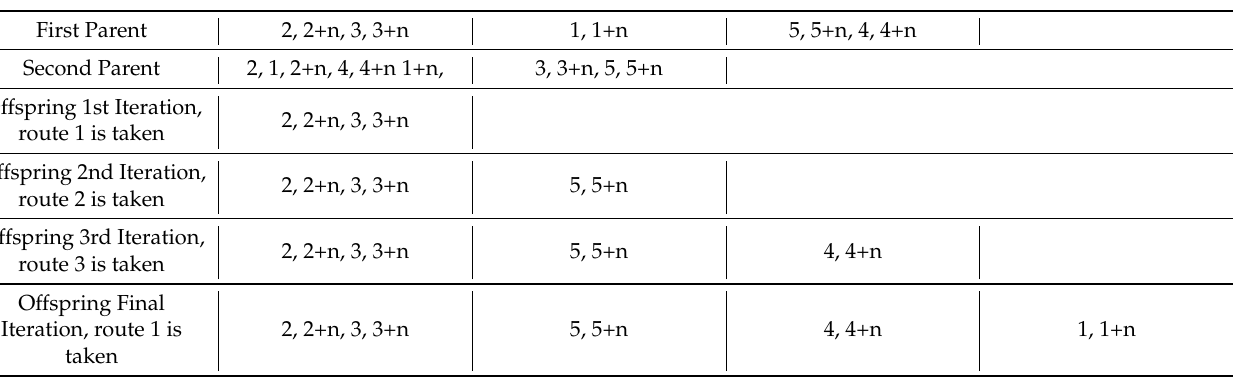
Figure 2. Example of crossover without ejection. The final offspring would then have all "small" routes removed and reinserted